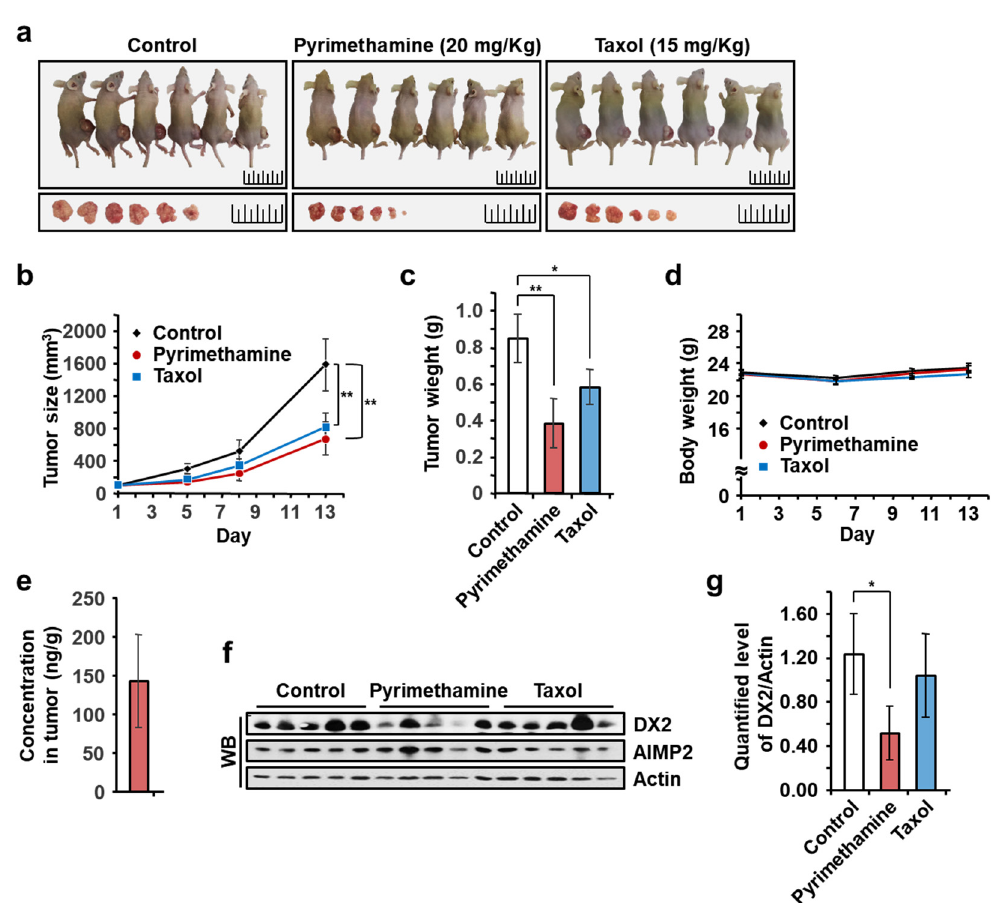
Figure 5. Pyrimethamine suppresses tumor progression in vivo. ( a – g ), Xenograft experiment for evaluating the in vivo tumor-suppressive e ff ect of pyrimethamine. Pyrimethamine (20 mg / kg / day) and Taxol (15 mg / kg / day) were intraperitoneally injected, and the tumor sizes ( b ) and body weights ( d ) were measured during the experimental period. After sacrifice, the mice and the excised tumors were photographed ( a ), and the tumors were weighed ( c ). The concentration of pyrimethamine ( e ) and the levels of endogenous DX2 and AIMP2 proteins ( f , g ) in the excised tumors were determined by LC-MS / MS and Western blot (WB) analysis, respectively. Average of the quantified values among tumors were presented as a bar graph ( g ). Control means the carrier without chemicals. Student’s two-tailed t -test was performed for statistical analysis (* p < 0.05, ** p < 0.01). The error bars denote the standard deviation (S.D.), and the data are shown as the mean ±